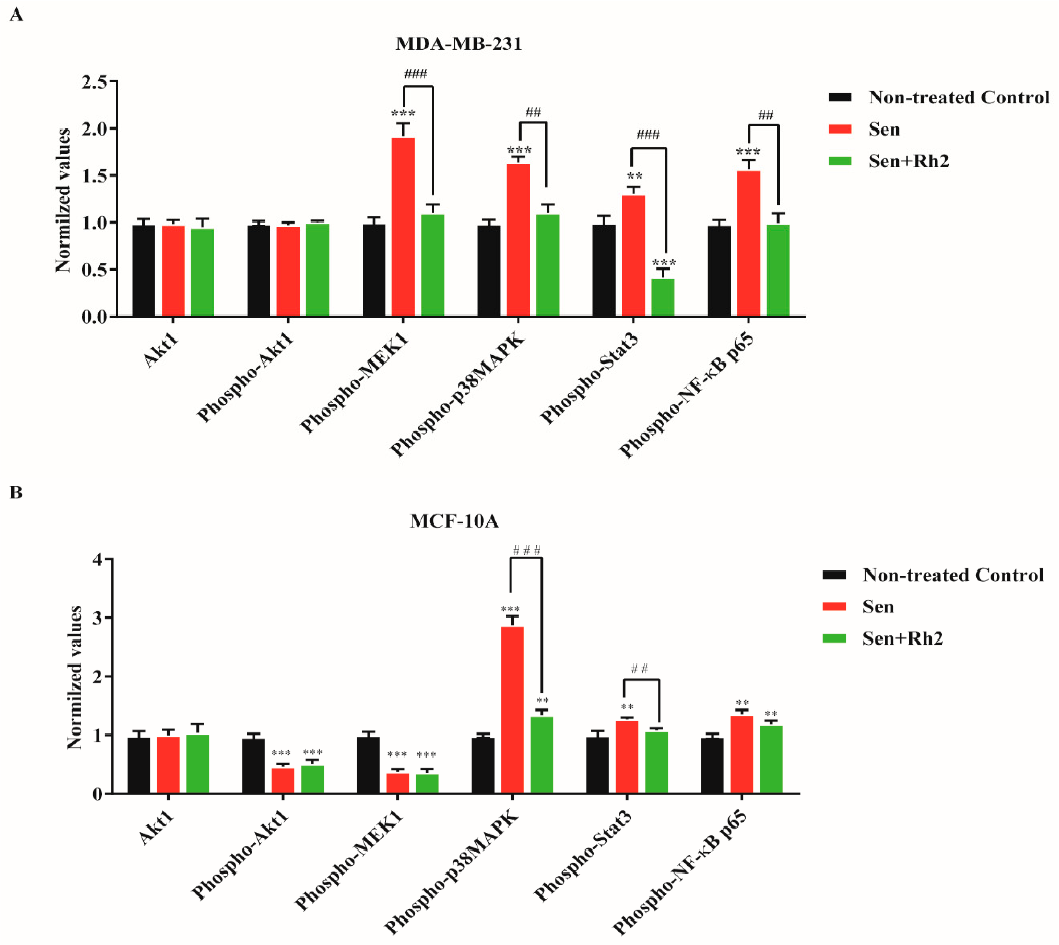
Figure 5. Rh2 suppressed potential signaling pathways regulating SASP in breast cell lines. Senescent MDA-MB-231 ( A ) and MCF-10A ( B ) cells treated with or without Rh2 were lysed and subjected to the Signaling Nodes Multitarget Sandwich ELISA assay. ** indicates p < 0.01 versus nontreated con; *** indicates p < 0.001 versus nontreated con. ## indicates p < 0.01 versus CM alone group. ### indicates p < 0.001 versus CM alone group.